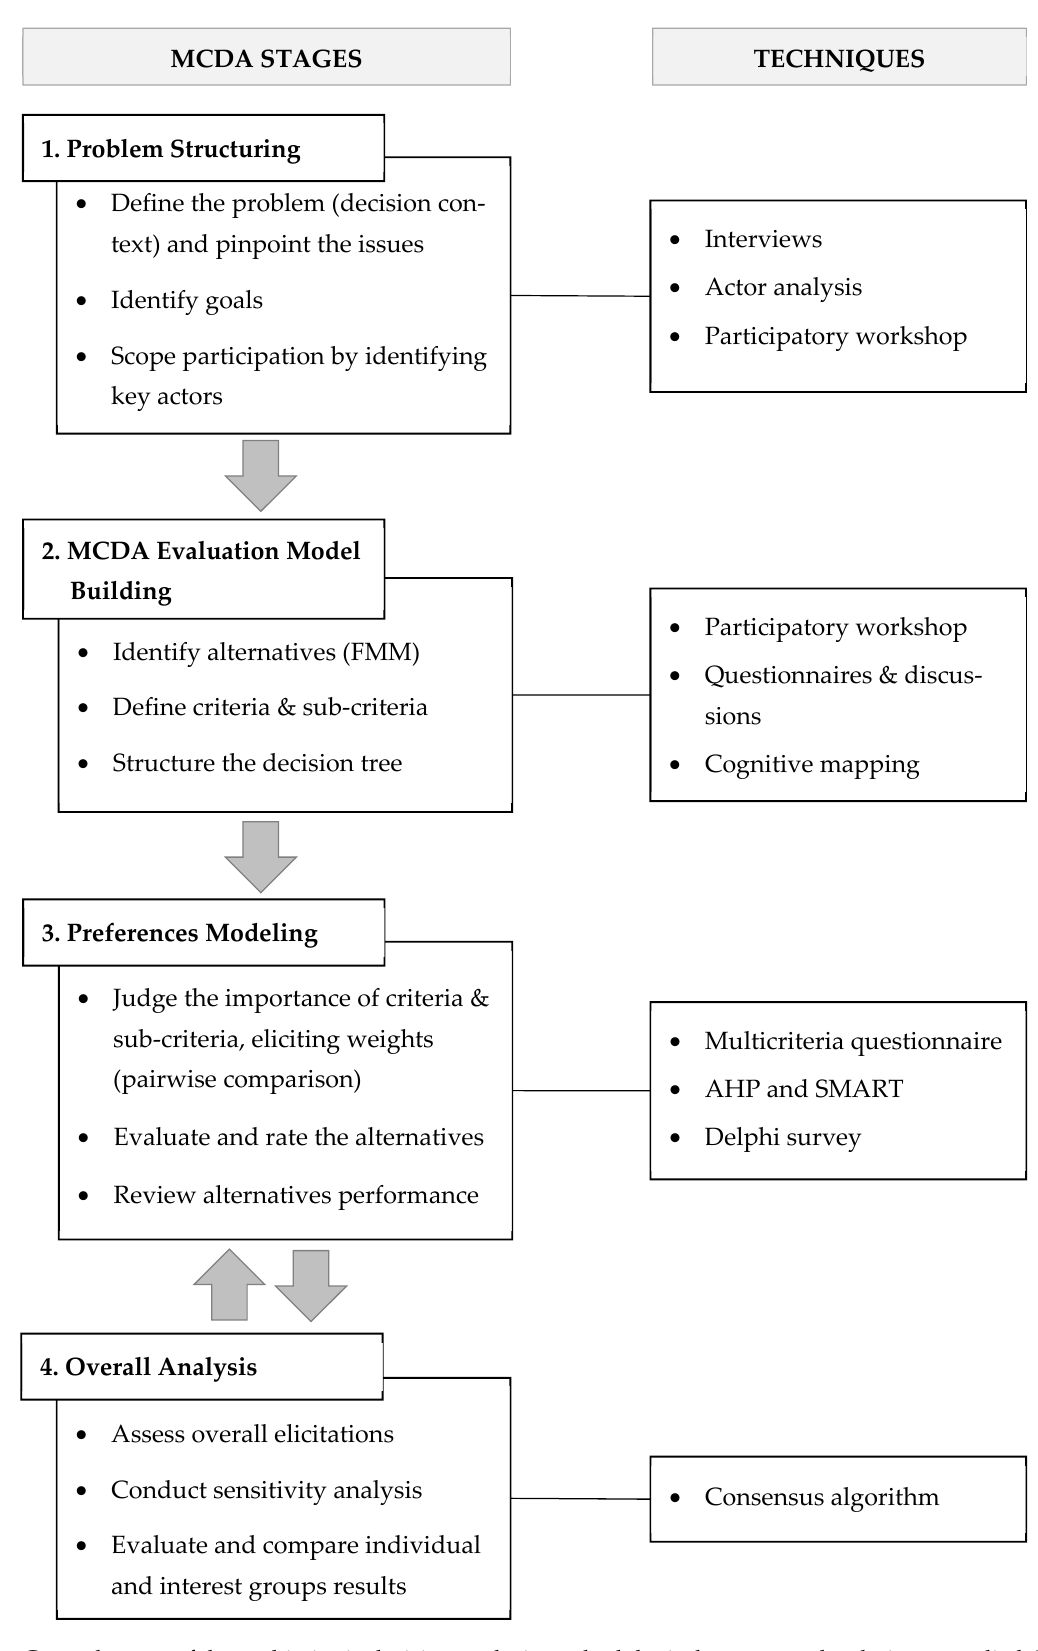
Figure 2. General stages of the multicriteria decision analysis methodological process and techniques applied. Modified from [4,11,34].